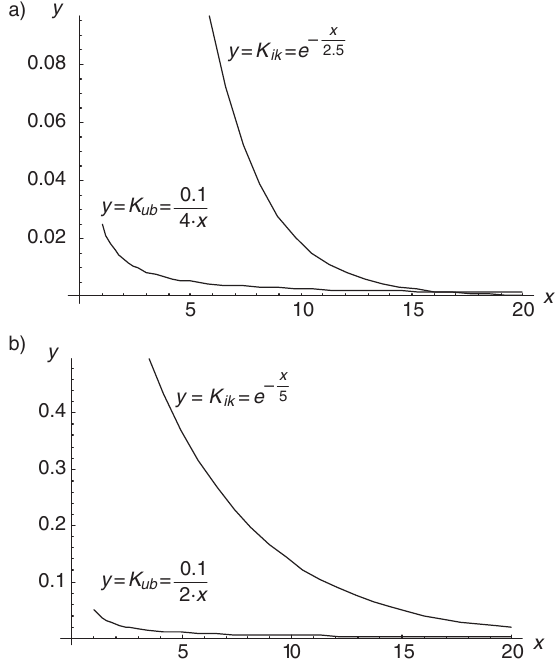
Fig. 4. Influence of coefficient K ub and K ik on potential number of groundings ( x (cid:2) distance to the coast in nm, D (cid:3) D ? ): a (cid:2) r z (cid:3) 0.1 nm, a i (cid:3) 2.5 nm; b (cid:2) r z (cid:3) 0.1 nm, a i (cid:3) 2.5